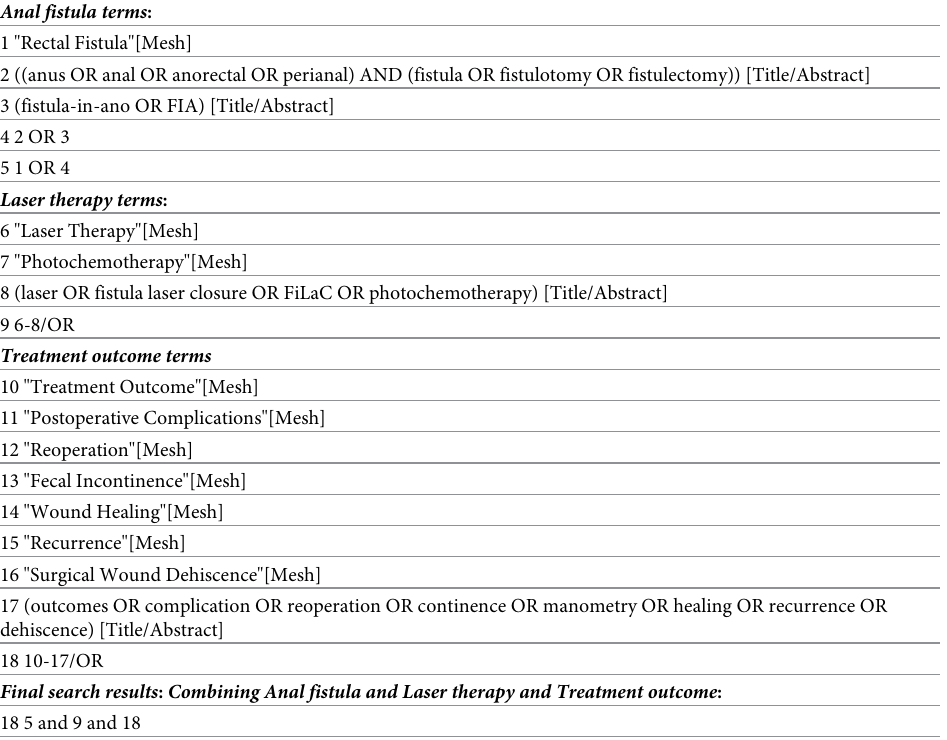
Table 1. Search strategy for Pubmed